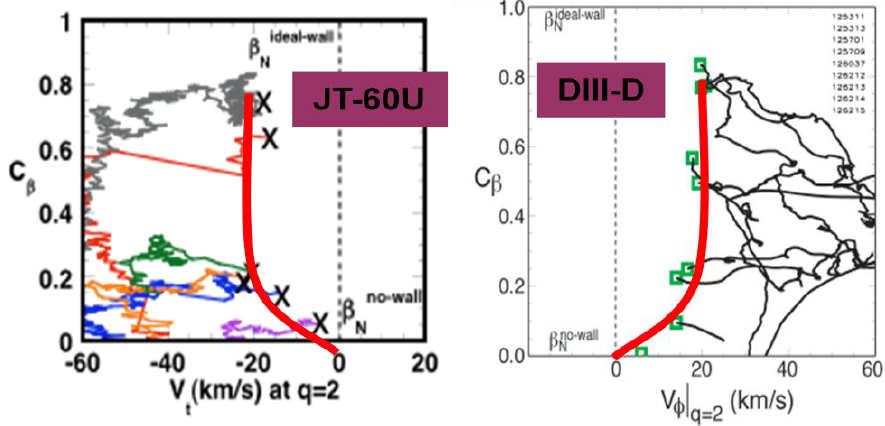
Figure 28. Demonstration of stabilization of RWM by small toroidal plasma rotation in JT-60U (left) [145] and in DIII-D (right)